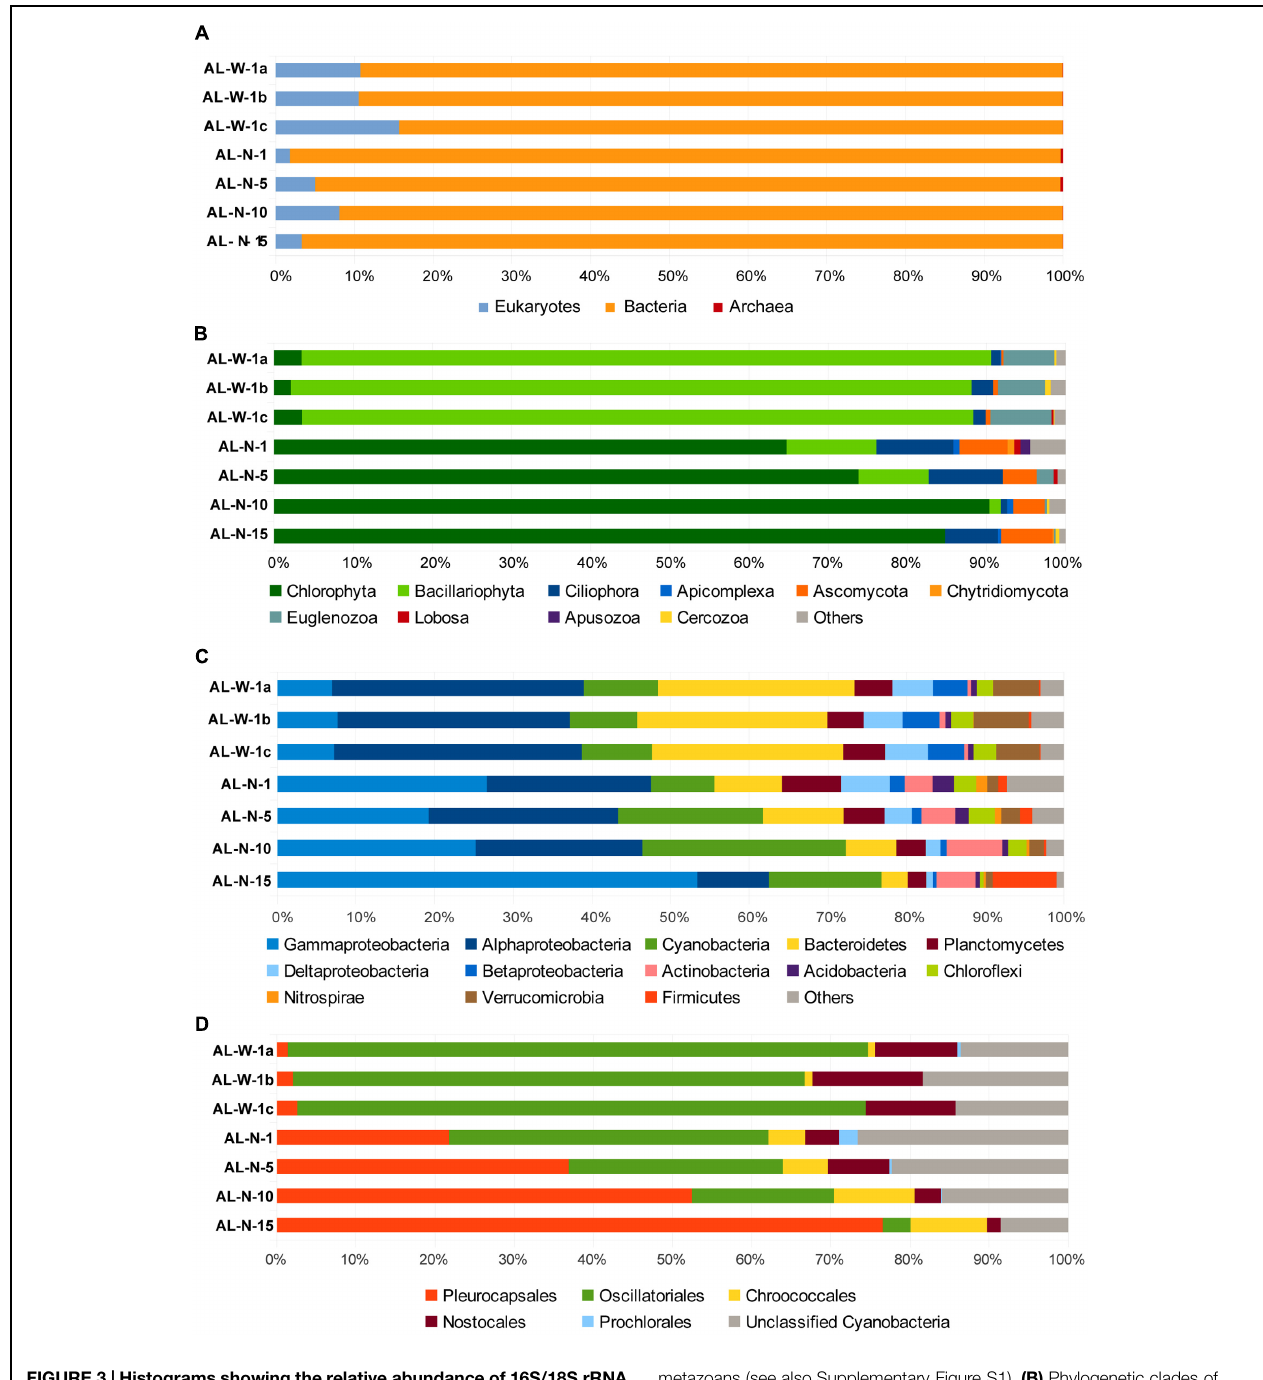
metazoans (see also Supplementary Figure S1). (B) Phylogenetic clades of microbial eukaryotes, (C) bacterial phyla or classes (for the Proteobacteria), and (D) cyanobacterial orders. Neither singletons nor chloroplasts were included (their proportions are shown in Supplementary Figures S2–S4).